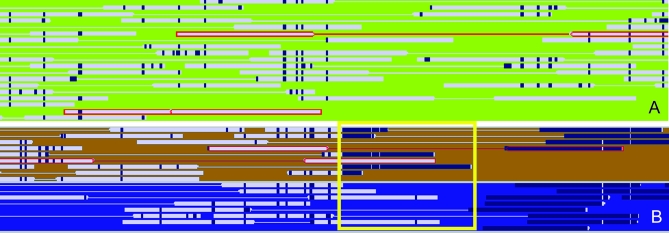
Recombination between Related Individuals Is Directly Observed in Some Sequence Reads(A) Diagram showing an area in contig 11277 with possible evidence for recombination between closely related strain variant types. Reads whose sequence type is a hybrid of a variant and the dominant strain types are outlined in red. The reads corresponding to the consensus (majority) sequence type are not shown.(B) Area of contig 11277 at approximately 140 kb where highly divergent sequence relative to the composite has inserted into three variants: the dominant strain variant (contig consensus sequence), as indicated by the upper read outlined in red, the brown strain (note that one individual sampled lacks the insert [lower read outlined in red]), and the blue strain. In the region identified by the yellow box, the contig 11277 consensus sequence appears to be a distinct Leptospirillum variant (dissimilar to both 5-way CG and UBA types) and the variant sequence (brown strain) is likely the pre-recombination 5-way CG-type sequence. Identity between contig 11277 and the sequence terminating the brown and blue strains is 72%. Recombinant reads are highlighted in red.